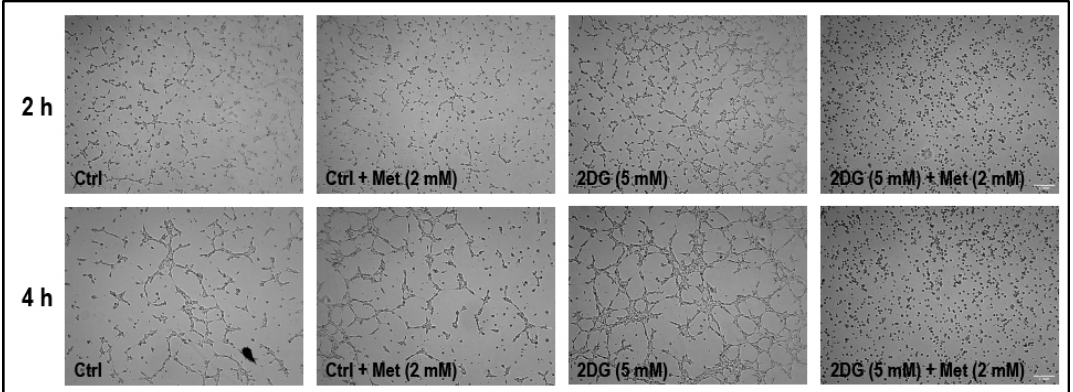
Figure 9. Representative microscopic images (from three experiments) from matrigel tubulogenesis assay shows the tubulogenic capacity of the cells under the different treatment conditions. It must be noted that the MMECs were treated for 24 h on 60 mm dishes prior to tubulogenesis assay. After 24 h in culture, the MMECs were trypsinized and harvested and seeded (20,000 cells/well) onto the matrigel in their respective treatment media/conditions. We intended to image the cells after 2 h, 4 h, 6 h, 12 h and 24 h (to match the 48 h time point for the other experiments) on a matrigel. However, during initial experiments, it was noted that the cells did not grow well beyond 4–5 h on a geltrex matrix, hence images of the cells were captured using a camera mounted on an inverted light microscope after 2 h and 4 h on a geltrex matrix. Scale bar = 1000 μ m.